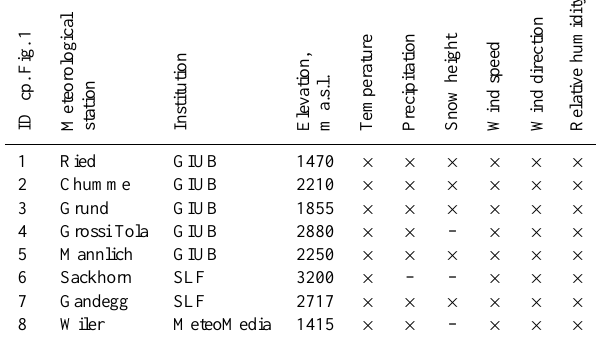
Table 1. Meteorological stations in the catchment with the param- eters measured, the elevation of the location, and the supporting